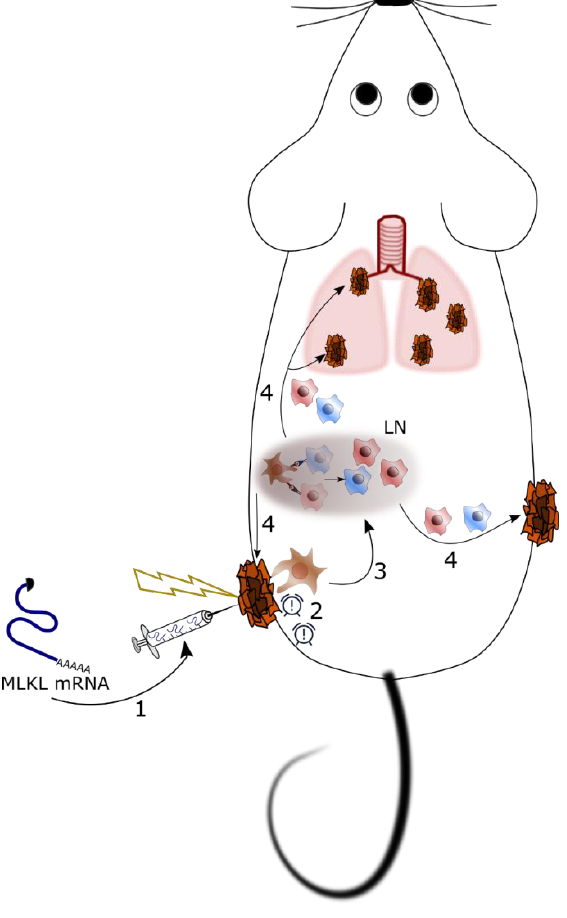
FIGURE 1: Proposed therapeutic mechanism of intratumor treatment with mRNA encoding MLKL. 1. In vitro transcribed hypo-inflammatory mRNA encoding MLKL is injected in an estab- lished tumor followed by electroporation. 2. MLKL-mRNA can enter cells in the tumor mass and evoke cell death with necrop- totic hallmarks. Necroptotically dying cells release alarm signals that attract immune cells. 3. DCs are attracted to the dying tu- mor cells and will take up tumor-specific antigens and subse- quently cross-present these in the draining lymph node (LN) to CD4 + and CD8 + T cells. 4. These resulting tumor neo-antigen- specific CD4 + and CD8 + T cells can than eliminate the treated as well as distal untreated